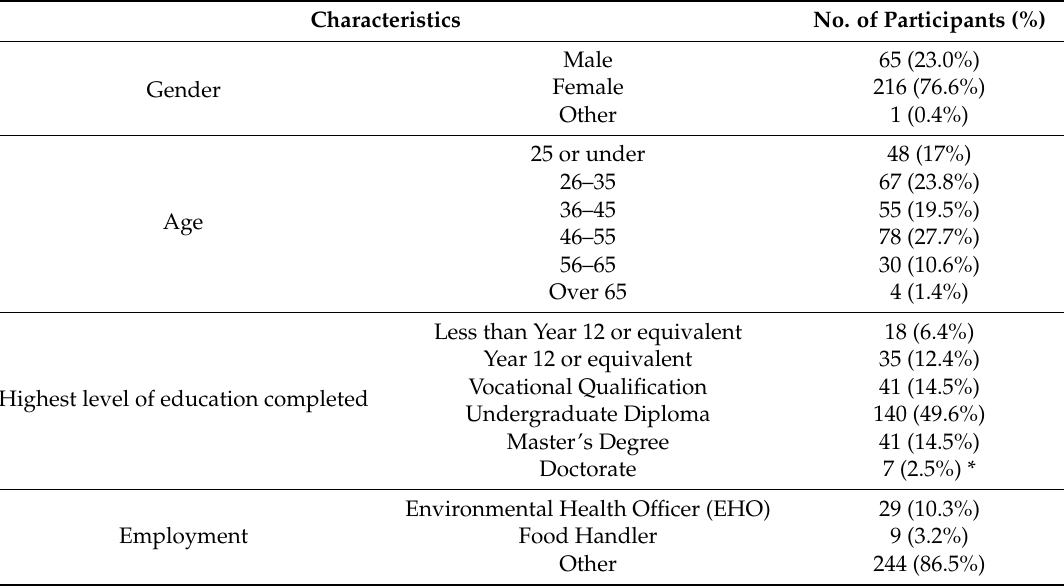
Table 1. Demographics of survey participants (n =